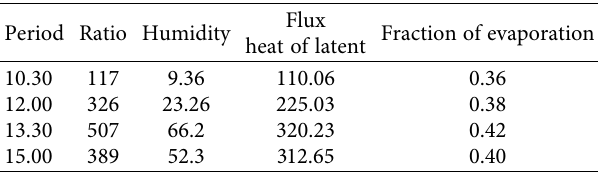
Table 2: Using energy balance, we calculate the evaporative per-